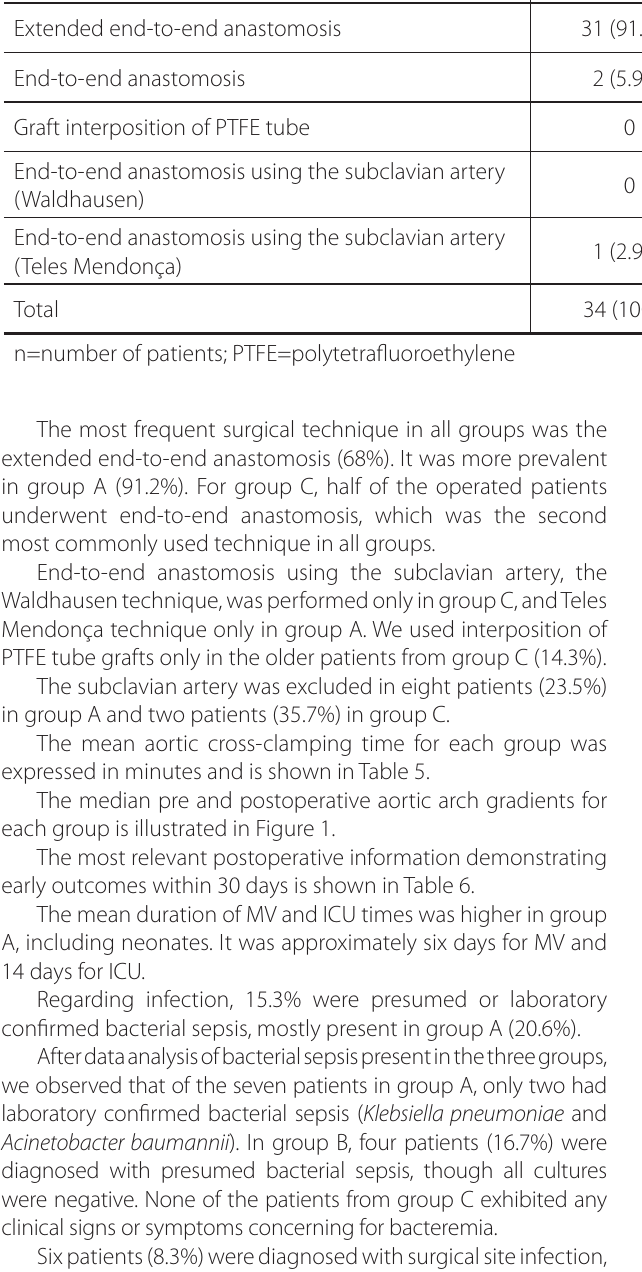
Table 4 . Surgical techniques for coarctation of the aorta repair. Procedures